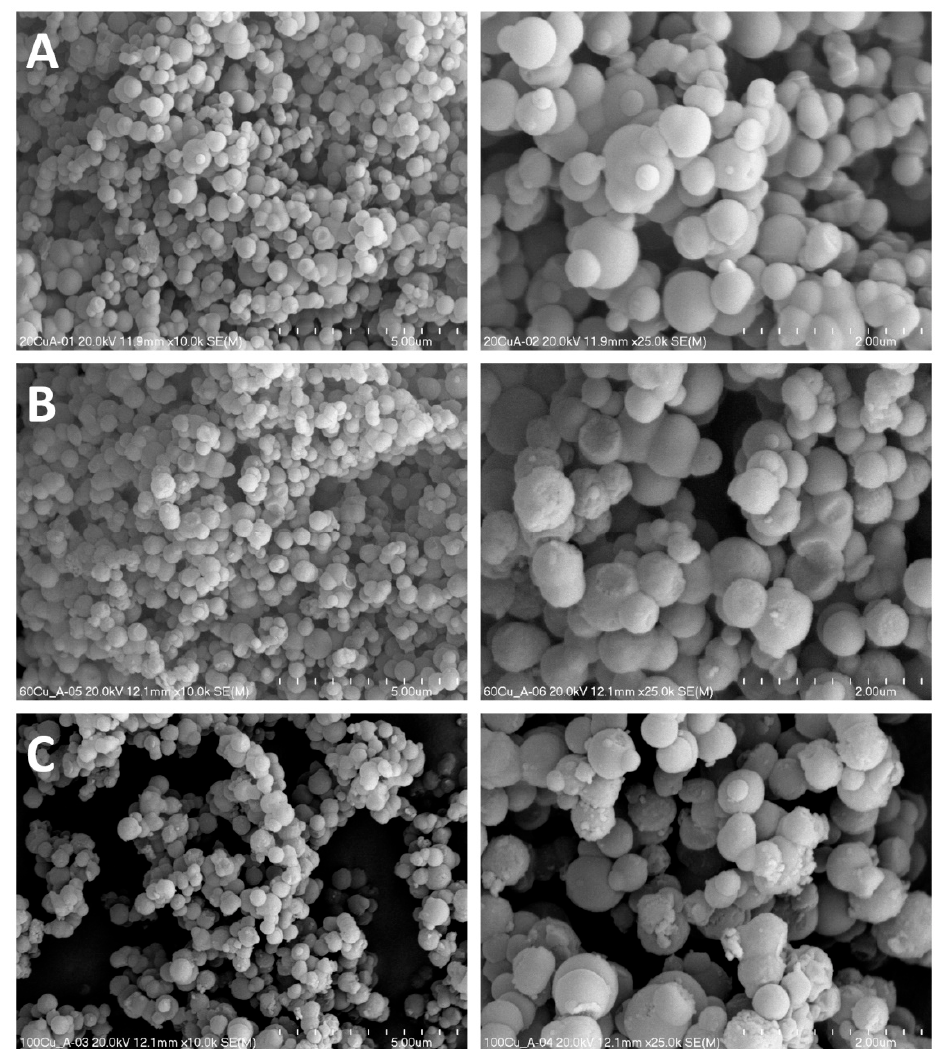
Figure 6. SEM images of the 20Cu-A ( A ), 60Cu-A ( B ) and 100Cu-A ( C ) samples at various magnifications.